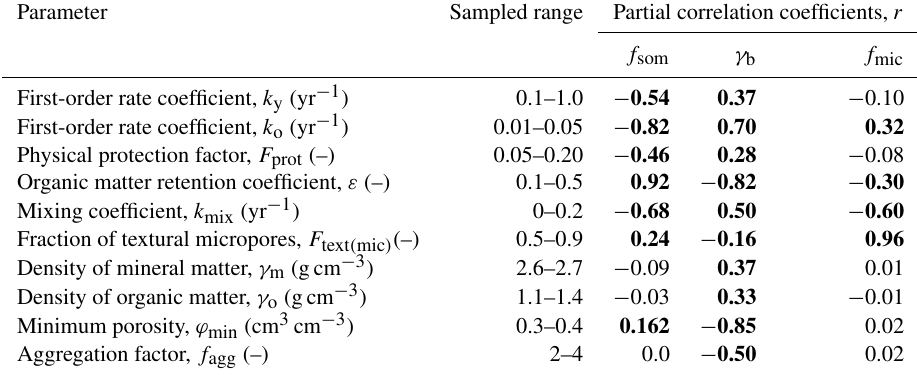
Table 1. Sampled parameter ranges and the Spearman rank partial correlation coefficients ( r ) between parameters and target outputs. Values marked in bold show a significant correlation ( p< 0 . 01). Note: f som – soil organic matter concentration, γ b – bulk density and f mic – fraction of